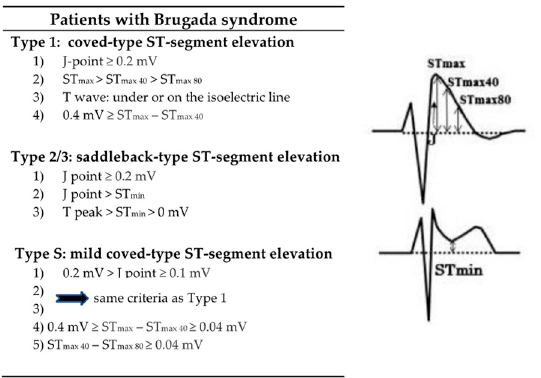
Figure 2. Brugada Syndrome—J-wave amplitude, ST-segment elevation analysis, inspired by Nishizaki et al., 2013